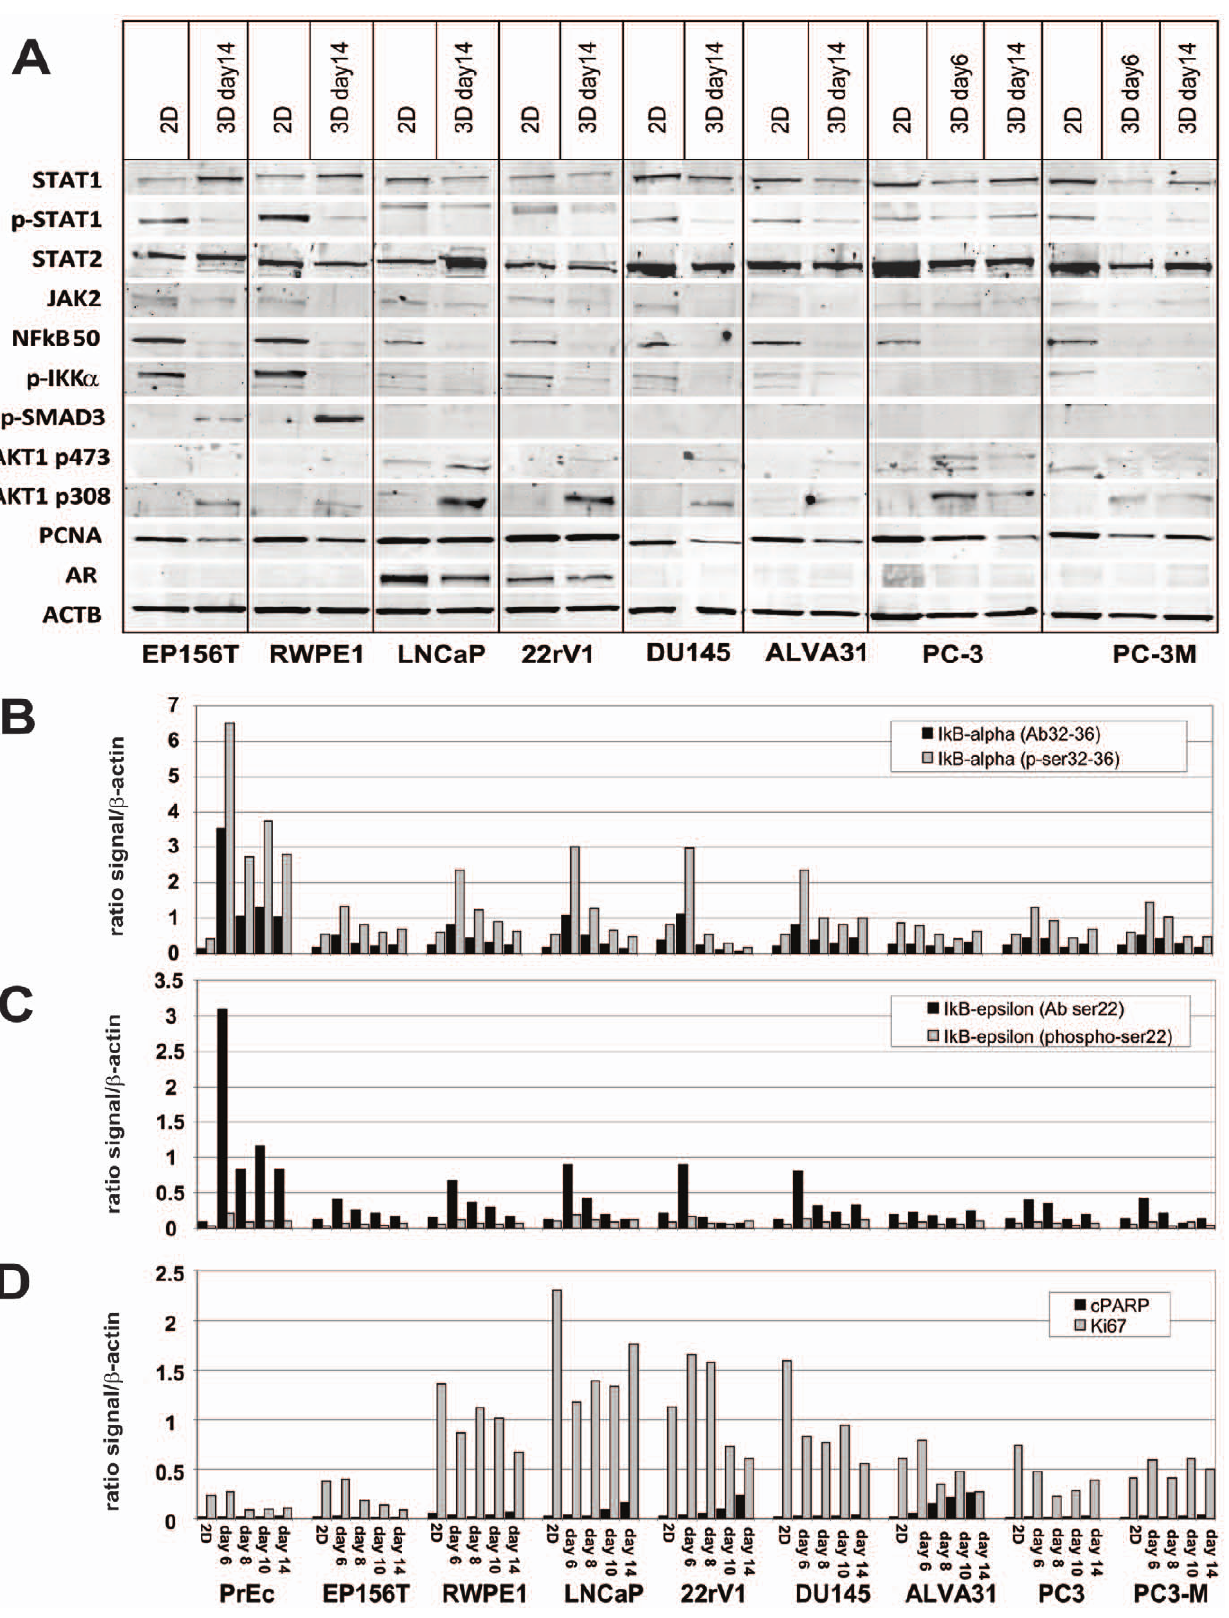
Figure 6. Altered expression of key signaling molecules, phospho-proteins and transcription factors in 2D versus 3D culture. A) Western blot analysis of various transcription factors (AKT1, STAT1, STAT2, IKK a , NFkB1 p50, SMAD3), androgen receptor (AR) and PCNA. B) and C) Protein lysate analysis of IkB a and IkB e (inhibitor of NF-kappaB) in cell lysates isolated from cells grown as monolayer in 2D or as spheroids in 3D culture. D) Lysate array